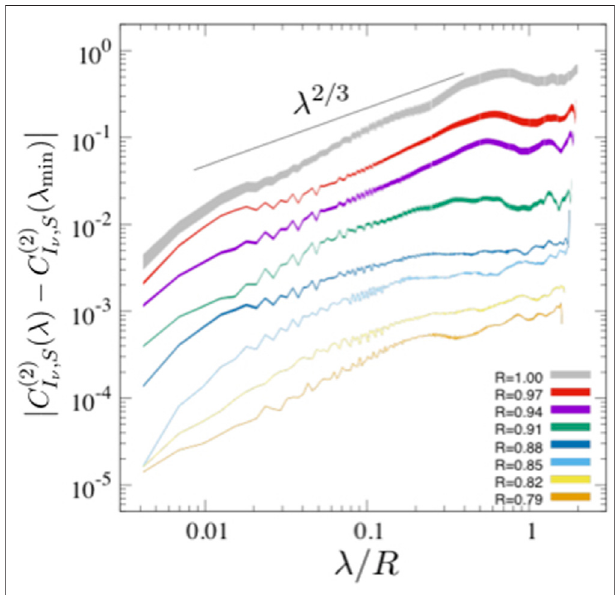
FIGURE 7 | Second-order correlation functions of the observed synchrotron intensities per frequency I ] , which imply the spectra of magnetic energy in SN 1572. To clarify the fl uctuating component of the correlation, the subtraction of | C ( 2 ) I ] ( λ ) − C ( 2 ) I ] ( λ min )| , where λ = | λ | and λ min ≈ 1.4 arcsec is the minimum separation distance between X ′ and X . The results are normalized to be ordered according to the radius of the concentric circles as R = 1.00 R SNR (gray), 0.97 R SNR (red), 0.94 R SNR (purple), 0.91 R SNR (green), 0.88 R SNR (blue), 0.85 R SNR (light blue), 0.82 R SNR (yellow), and 0.79 R SNR (orange), from top to bottom. Reproduced form Shimoda et al. (2018a, Monthly Notices of the Royal Astronomical